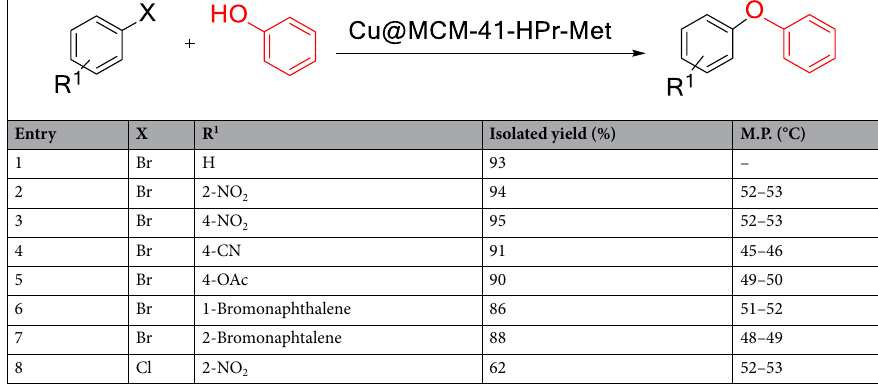
Table 6. The reaction of aryl halides with phenols in the presence of Cu@MCM-41-HPr-Met as a catalyst.